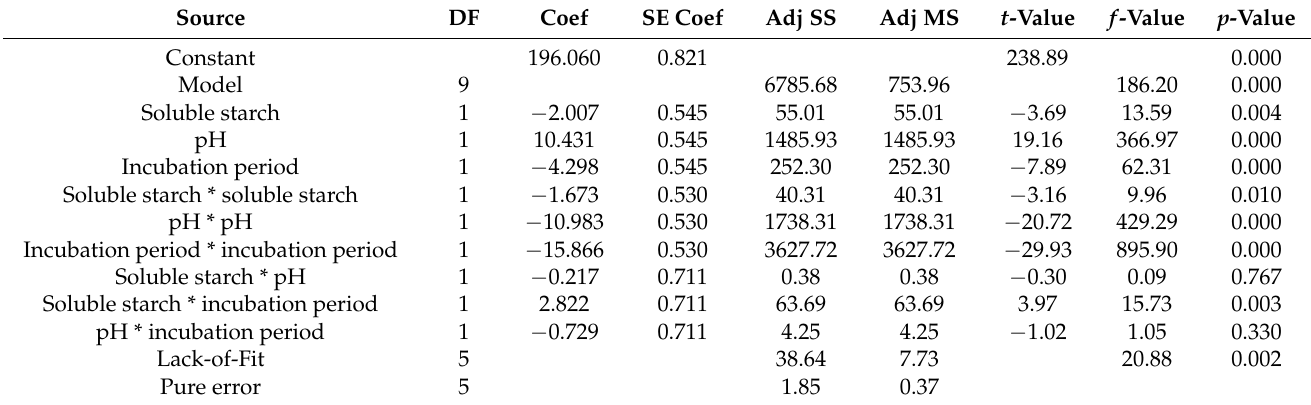
Table 5. ANOVA of CCD model using RSM of amylase yield in Bacillus sp. H7.